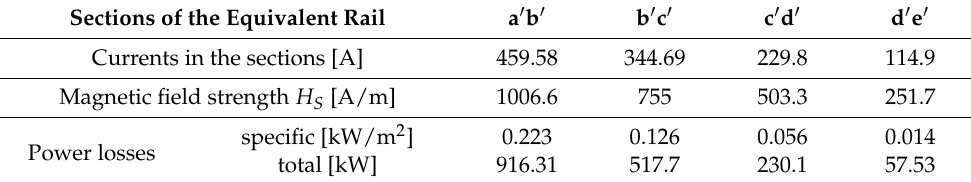
Table 3. Power losses in the equivalent